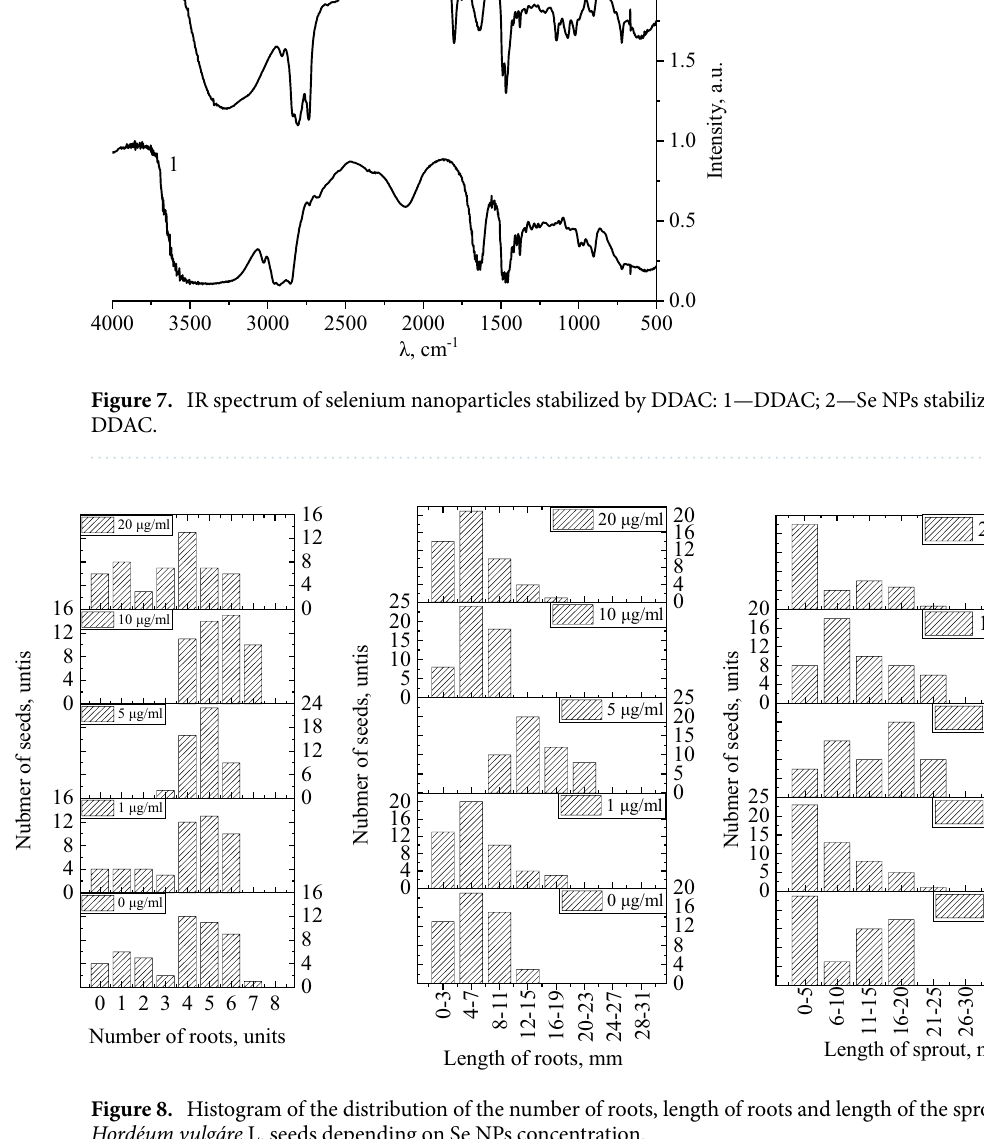
Figure 8. Histogram of the distribution of the number of roots, length of roots and length of the sprout of Hordéum vulgáre L. seeds depending on Se NPs concentration. Experimental